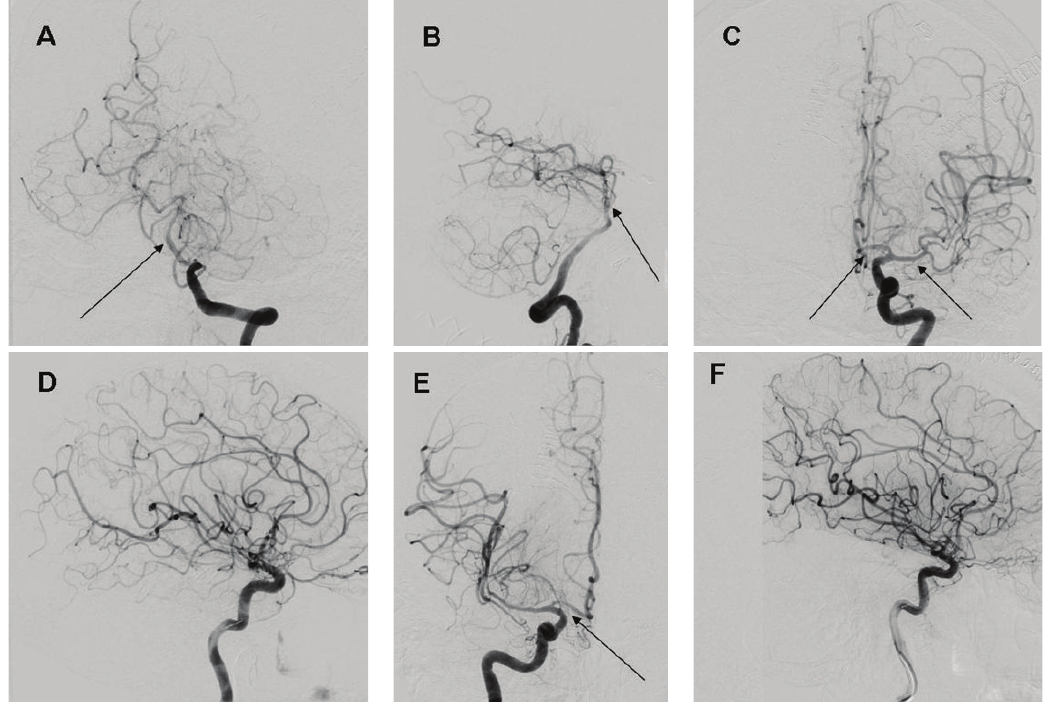
Figure 4: DSA performed 1.5 hours after milrinone administration. DSA = digital subtraction angiogram. (A) AP projection of a left vertebral artery injection displaying good opacification of the basilar artery trunk (black arrow). (B) Lateral projection of left vertebral artery injection displaying good opacification of the basilar artery trunk. (C) AP projection of a left internal carotid artery injection displaying resolution of all left sided vasospasm and normal appearing proximal anterior and middle cerebral arteries (black arrows). (D) Lateral projection of left internal carotid artery injection displaying no distal MCA vasospasm. (E) AP projection of right internal carotid artery injection displaying improvement in proximal middle cerebral artery spasm, with mild residual stenosis (black arrow). (F) Lateral projection of a right internal cerebral artery injection displaying no distal small vessel